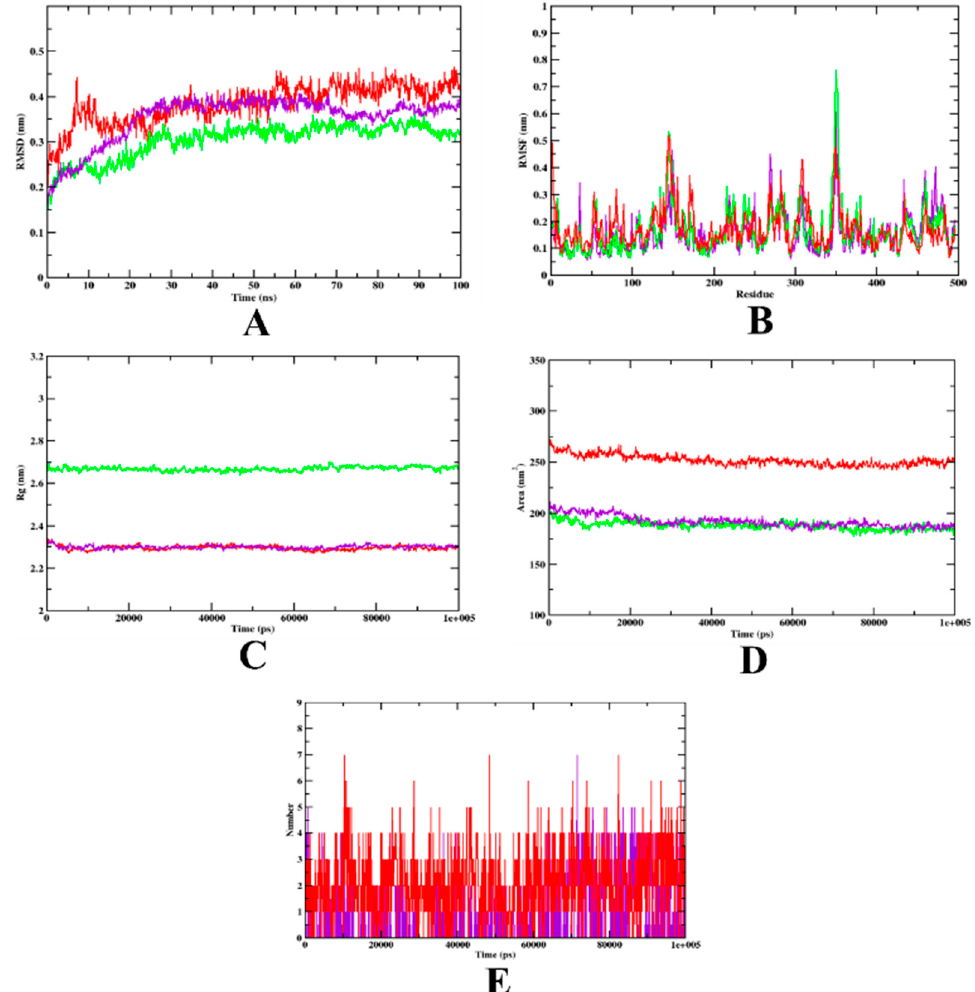
Figure 6. Analysis of RMSD, RMSF, Rg, SASA, and the number of hydrogen bonds of isoeugenol- (purple) and acarbose-bound (red) α -amylase complexes, as well as apo-protein α -amylase (green), at 100 ns. ( A ) Time evolution of RMSD values of both the complexes along with the protein. ( B ) RMSF. ( C ) Radius of gyration (Rg). ( D ) SASA. ( E ) Hydrogen bonds.